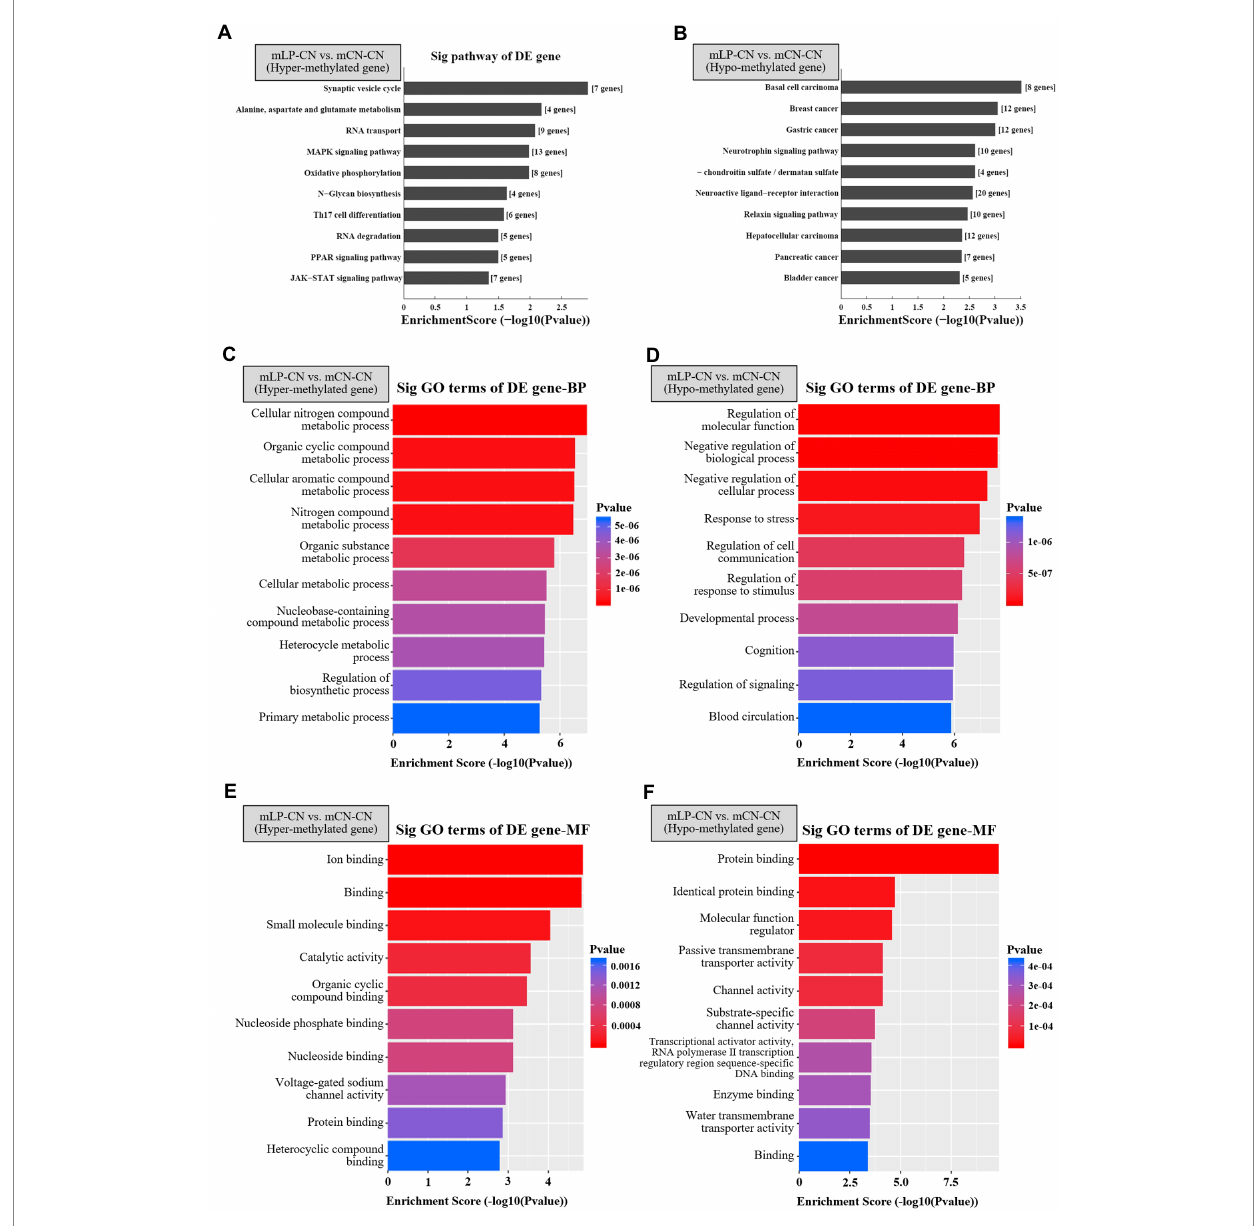
FIGURE 2 Top 10 signaling pathways of differentially expressed genes detected by methylation arrays in the kidney. Top pathways enriched in (A) hypermethylated or (B) hypomethylated genes in the mLP-CN group compared to the mCN-CN group are shown. Gene ontology of differentially expressed hypermethylated genes due to maternal low-protein intake for (C) biological process (BP) and (E) molecular function (MF) terms. Gene ontology of differentially expressed hypermethylated genes due to maternal low protein intake for (D) BP and (F) MF terms. Ten top gene ontology terms are shown. p < 0.05 was considered significant and –log10( p value) was calculated as the Enrichment Score. Sig, signaling; DE, differential expression; GO, gene ontology; BP, biological process; MF, molecular function; mLP-CN, maternal low-protein diet and control diet in offspring; mCN-CN, maternal control diet and control diet in